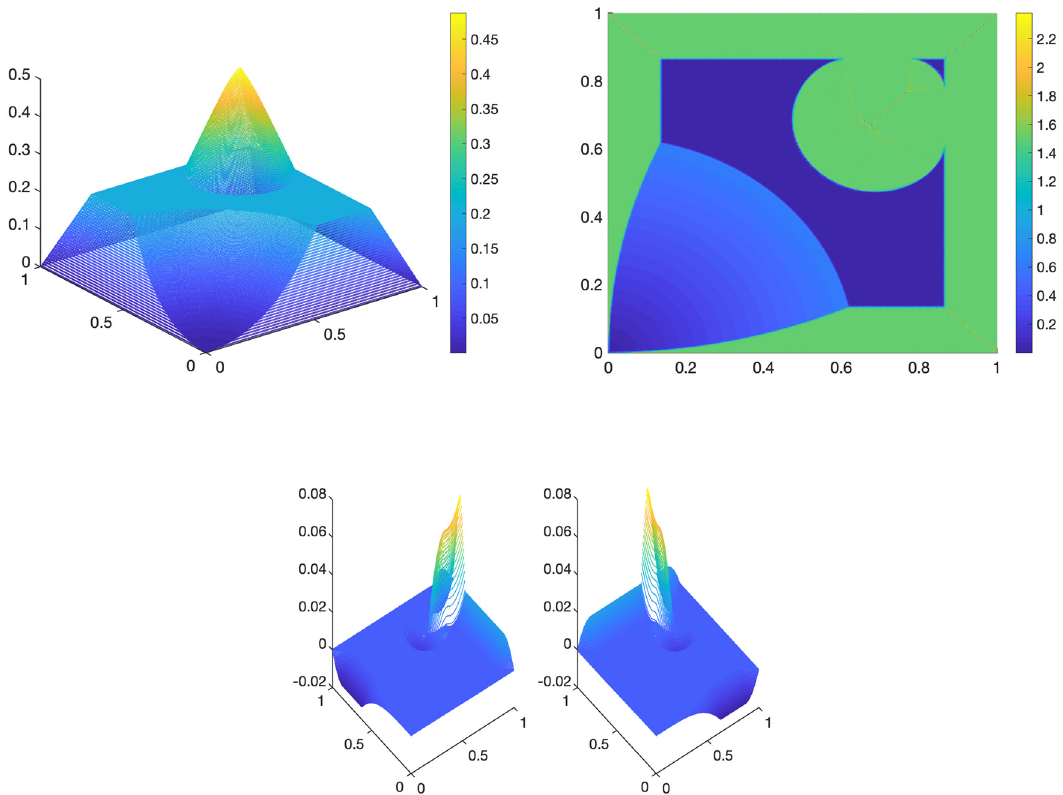
Figure 7: Example 2 ( α 1.5 = ) . Top row: u h and ∣ ∣ u h 2 ∇ . Bottom row: p